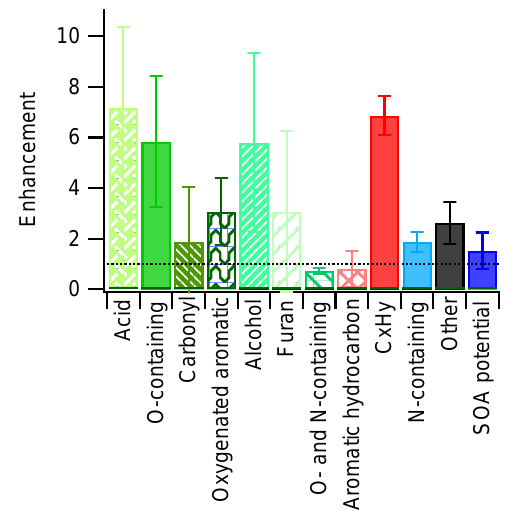
Figure 2. Enhancement (average value (mgkg − 1 ) of experiments 2 and 3 relative to the average value of experiments 1, 4 and 5) in each NMOG functional group category and for SOA formation potential. Total SOA formation potential is determined using the primary EF of each NMOG identified as a SOA precursor and literature SOA yields and assumes complete consumption of each NMOG with ag- ing (see text for details). Error bars correspond to one sample stan- dard